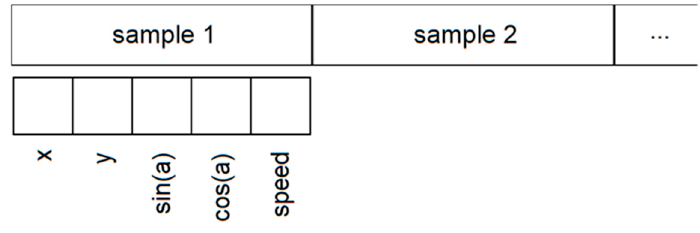
Figure 4. The representation of the past trajectory. Each trajectory sample is de fi ned by the ( x , y ) position, a tuple (sin( a ), cos( a )) representing the heading angle a , and the instantaneous speed. For our problem, the x coordinate is normalized between –10 m and 10 m relative to the center line of the road. The y coordinate is normalized between –150 m and 150 m.